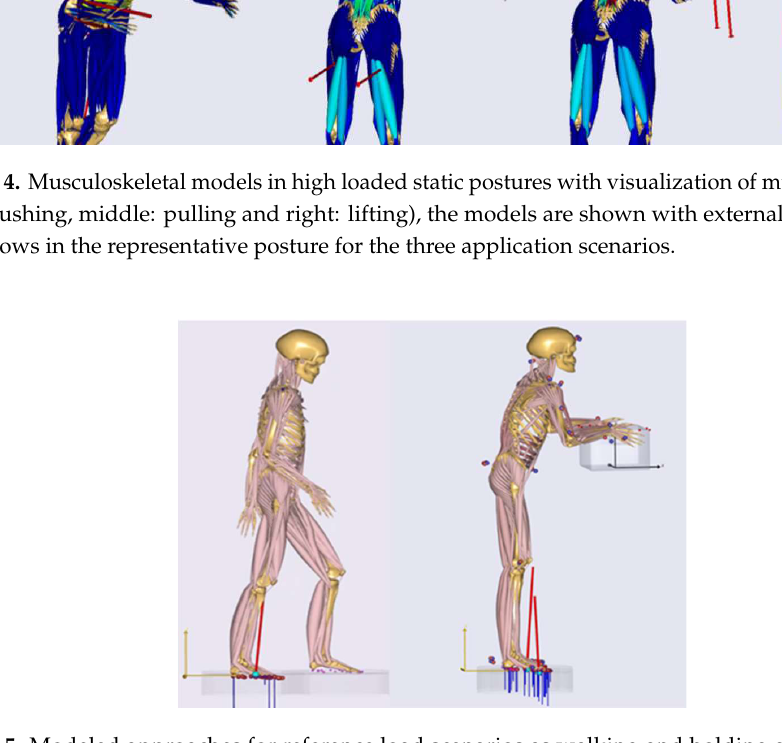
Figure 5. Modeled approaches for reference load scenarios as walking and holding a box. The joint force and moment magnitudes were taken within visualized postures in the walking model from the right knee and box holding